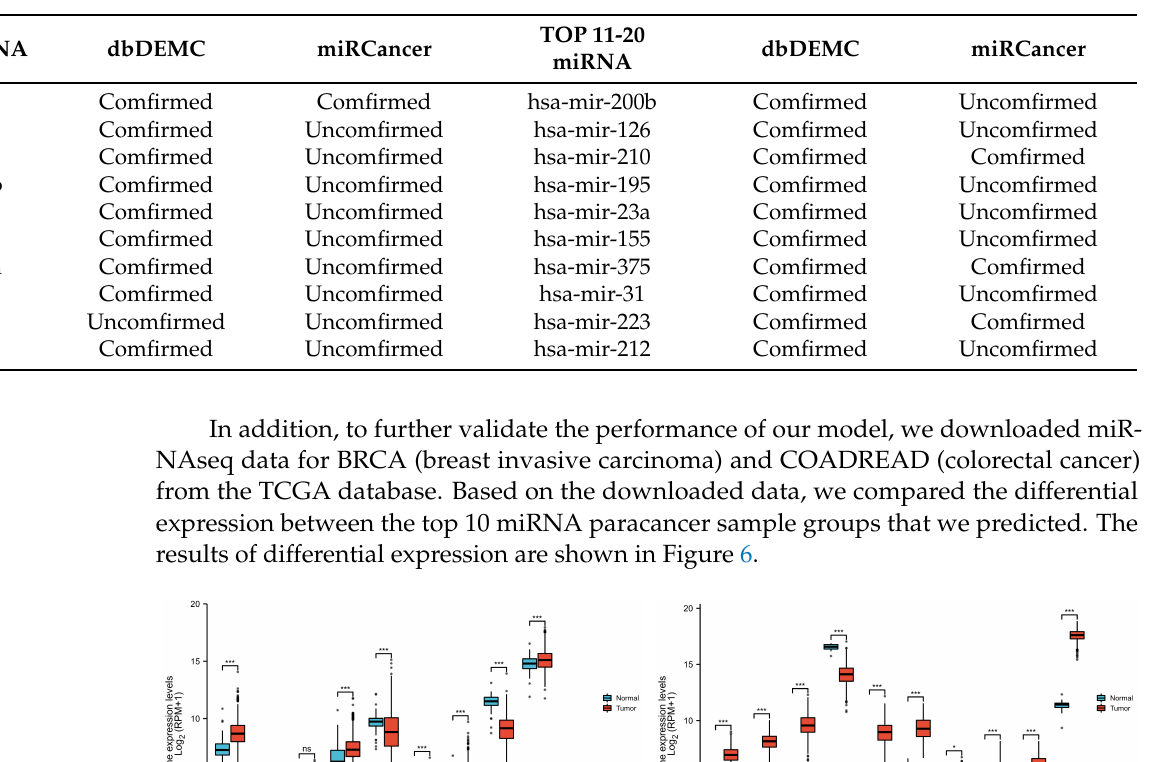
Table 8. Top 20 kidney neoplasm-related miRNAs predicted by SGAEMDA based on HMDD v2.0.